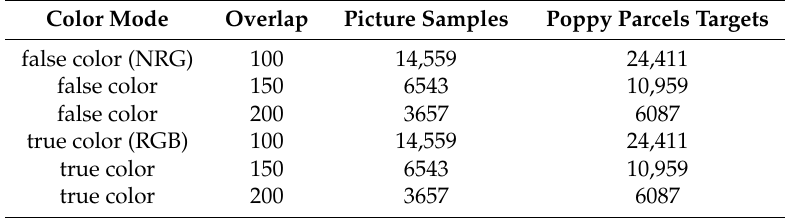
Table 3. Information of the six datasets. NRG: near infrared–red–green, RGB: red–green–blue.